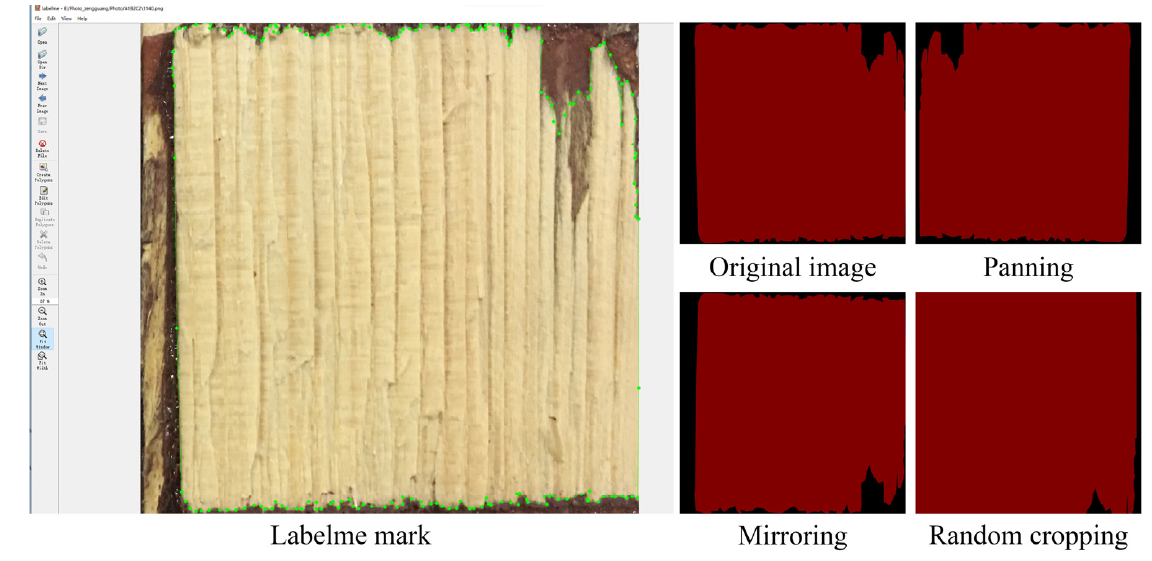
Figure 4. Image augmentation technology.